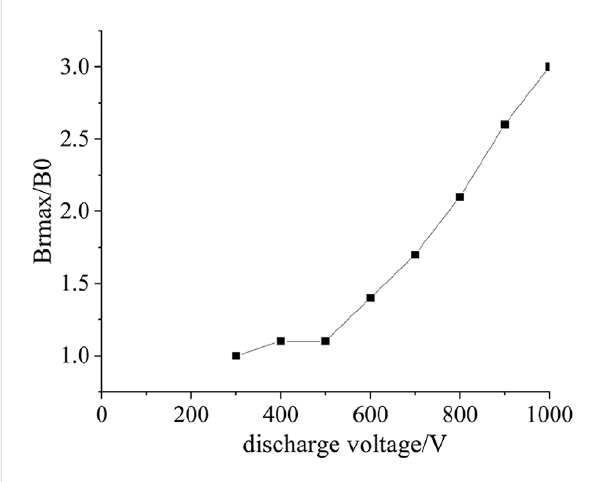
FIGURE 5 Magnetic fi eld increased with the increase of discharge voltage.